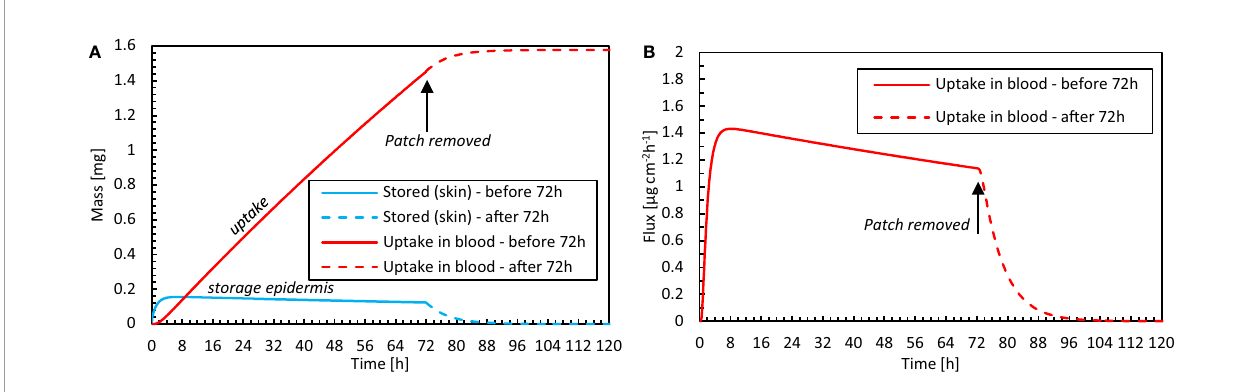
FIGURE 10 | (A) Amount of drug stored in the epidermis [m ep,stor (t)] and the cumulative amount of drugs taken up by the blood fl ow m bl,up (t) as a function of time for the case where the patch is removed after 72 h. (B) The corresponding fl ux that is taken up by blood (g bl,up ) as a function